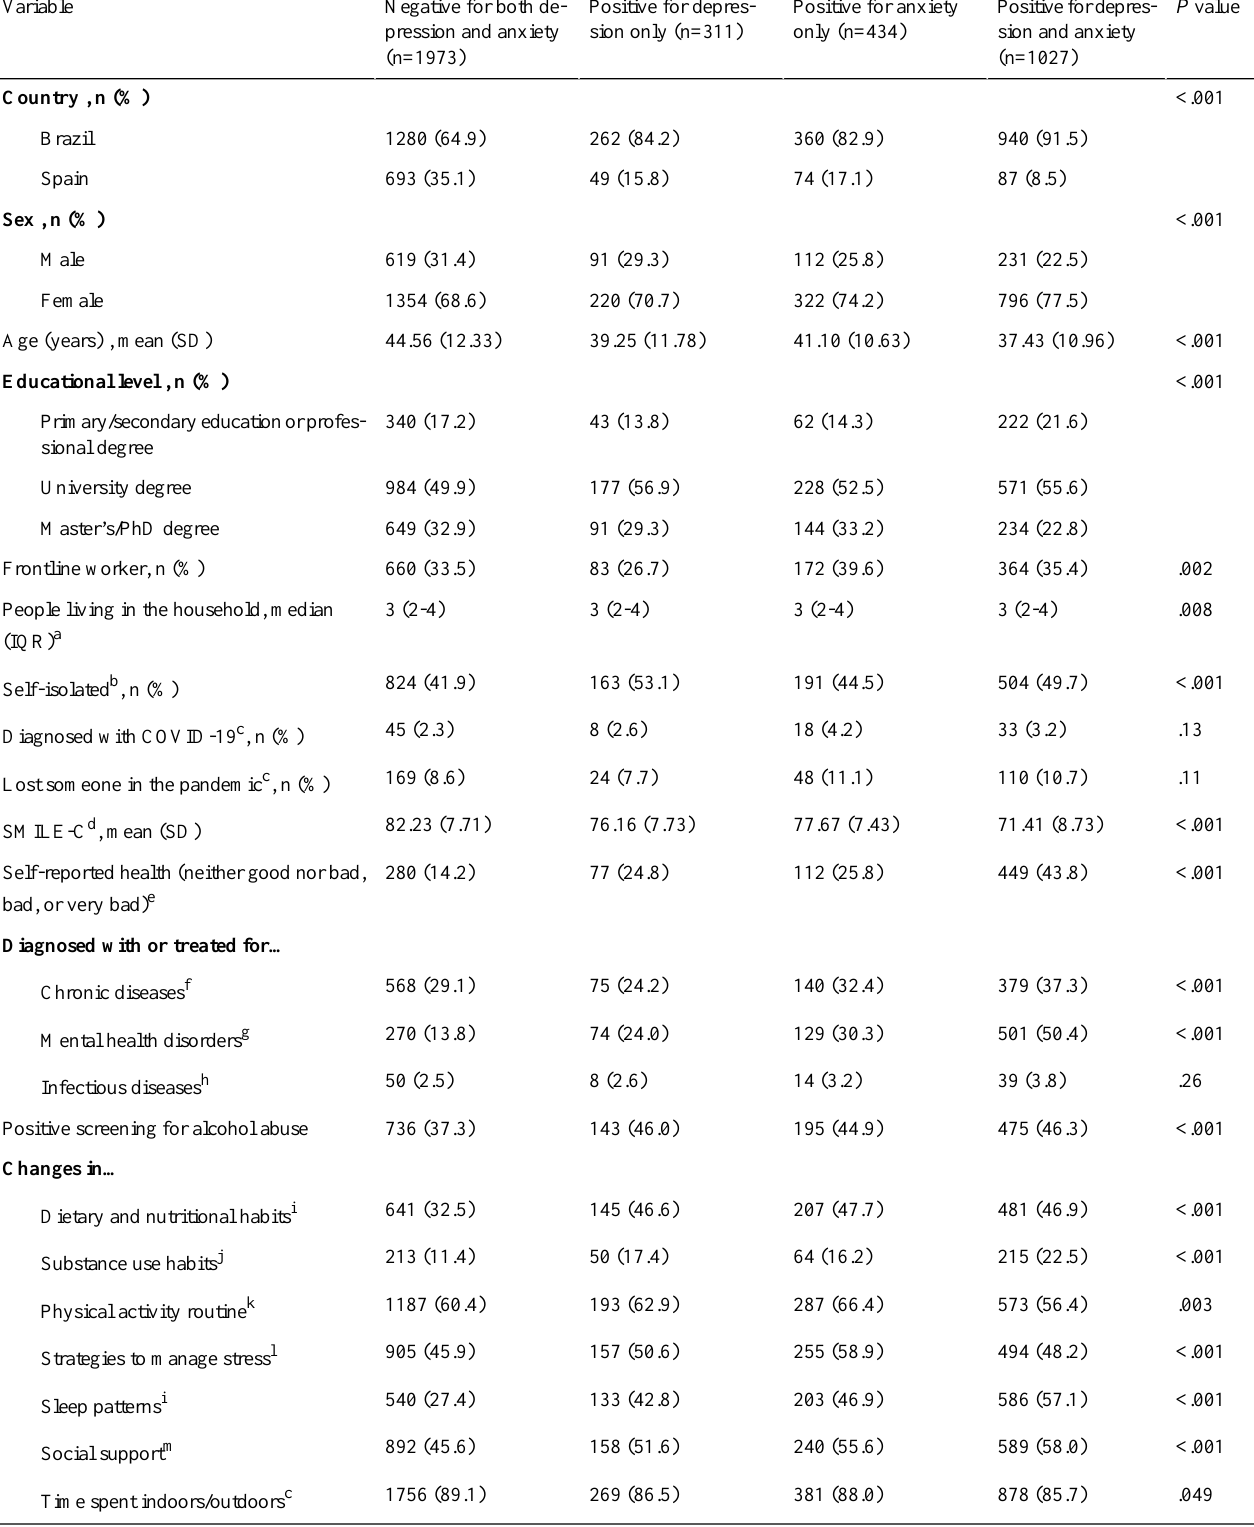
Table 2. Demographics, COVID-19 experience, lifestyle, and self-reported health conditions by mental health outcomes among essential workers from Brazil and Spain (N=3745), April to May